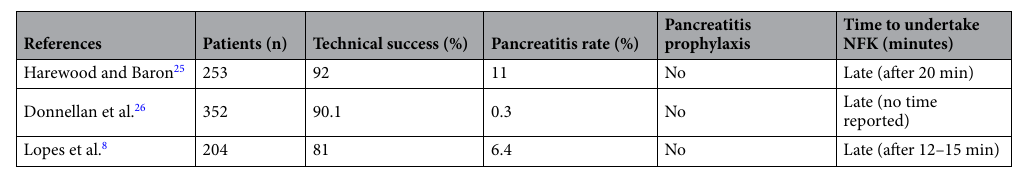
Table 5. Case series evaluating outcomes of needle-knife